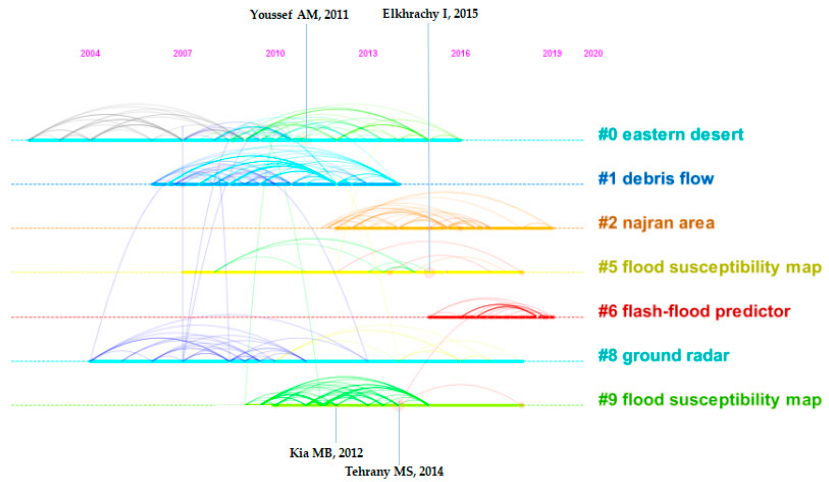
Figure 7. Timeline view of the citation trends identified in the 248 included articles. In the timeline view, the references of the same cluster are placed on the same horizon- tal line. In the timeline view, the number of references in each cluster can be clearly seen. More references in the cluster representing the cluster are more important. The cluster labelling on the right shows the research hotspot category associated with each reference. The circle in the figure represents the circle of the citation directory tree, the color at the center of the circle represents the year of the reference publication (the color corresponds to the year at the top of the view in the figure), and the size of the circle represents the frequency of citations. The cluster label name on the right indicates the research hotspot category related to the references in the cluster. Gray represents the earlier publication year, and red represents the most recent publication year. The longer color line segment indicates that the citation has a large time span, and its research hotspot is the subject that people have paid attention to for a long time. The red color at the outermost layer of